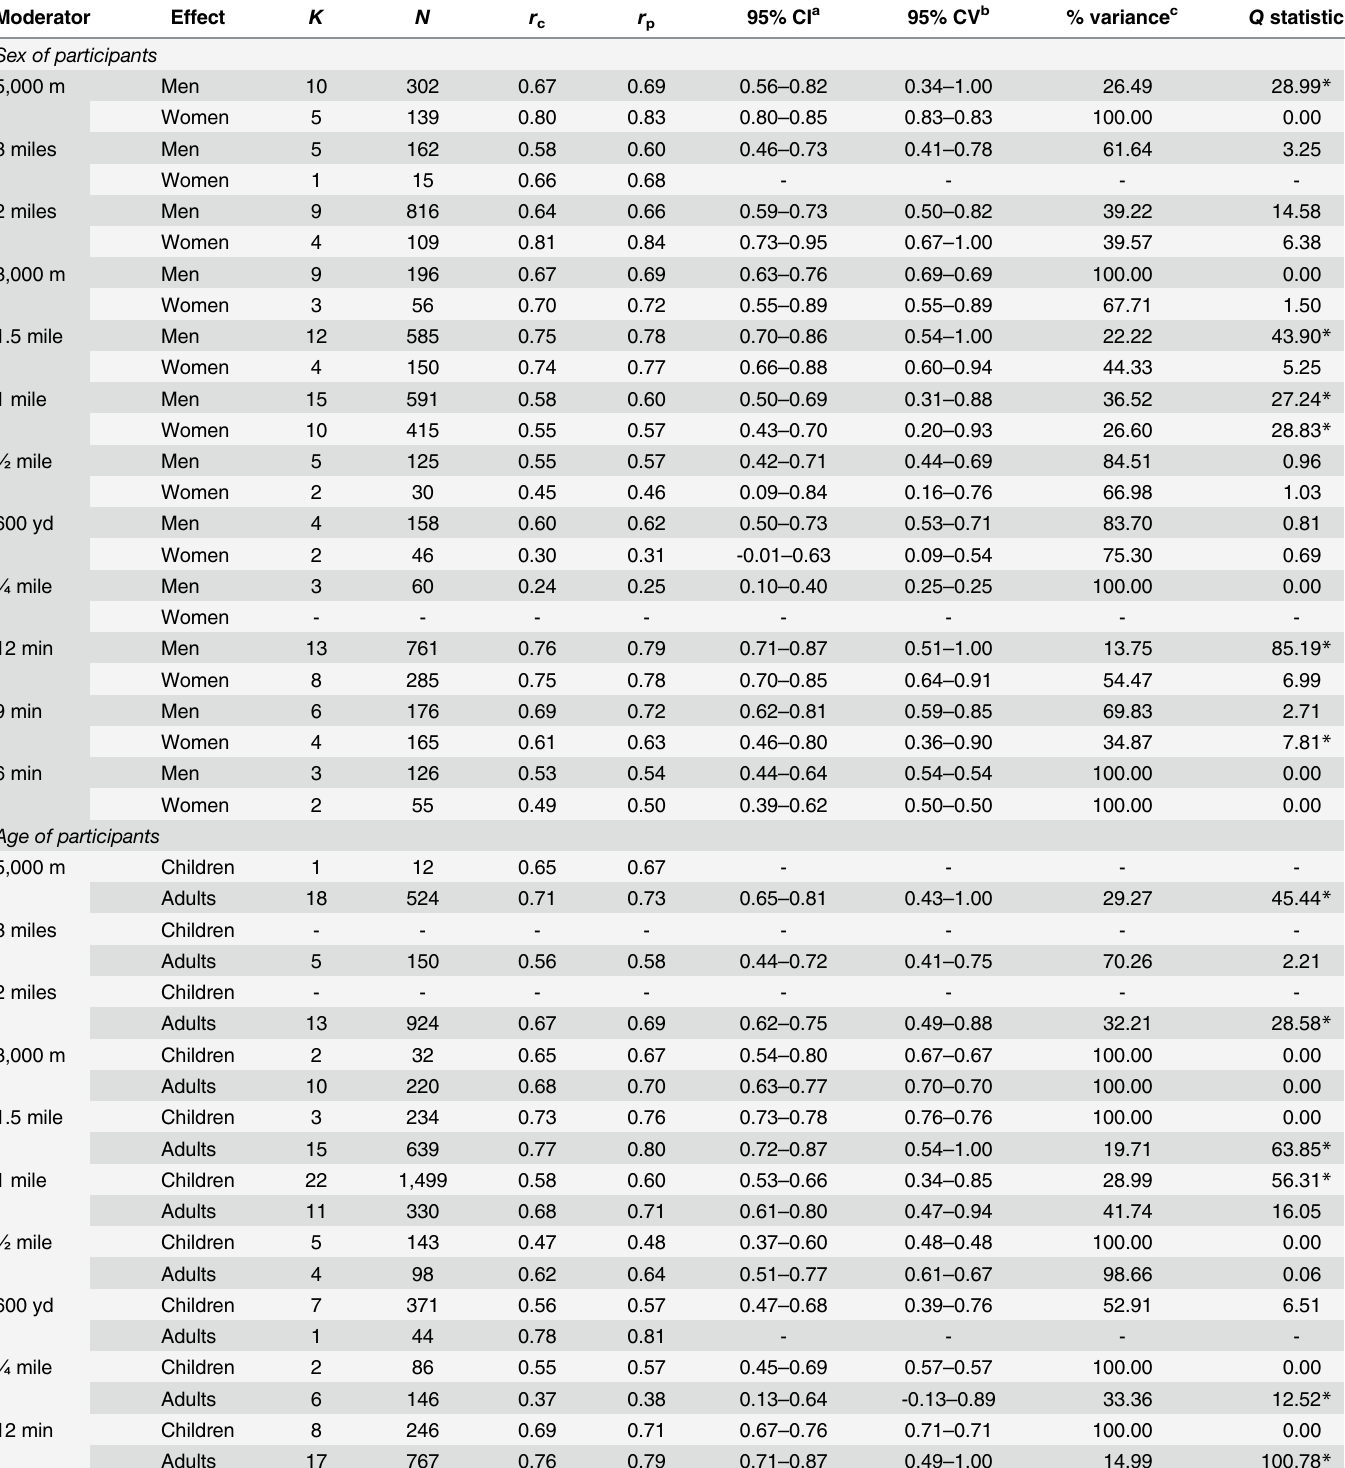
Table 2. Results of the between-study moderator analyses for criterion-related validity correlation coefficients across the distance- and time- based walk/run field tests †